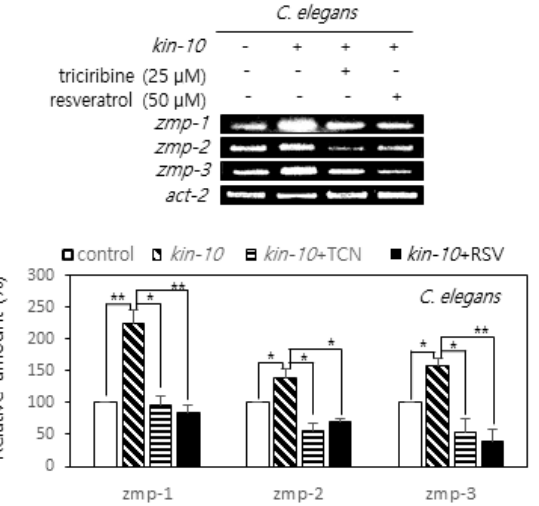
Figure 4. Effect of triciribine and resveratrol on the expression of matrix metalloproteinases (MMPs) orthologs induced by CK2 down-regulation in nematodes. Age-synchronized worms at the L4 stage were fed on the control or kin-10 RNAi plates containing 25 μ M triciribine or 50 μ M resveratrol for three days. Lysates from nematodes were utilized in RT-PCR using specific primers. PCR products were resolved on a 1.5% agarose gel. Representative data from three independent experiments are shown ( top ). Representative data from three independent experiments are shown. Act-2 mRNA served as the loading control. Graphs represent the quantitation of the mRNA levels of each gene relative to that of act-2 ( bottom ). TCN, triciribine; RSV, resveratrol. Data are mean ± SEM. * p < 0.05; ** p < 0.01.